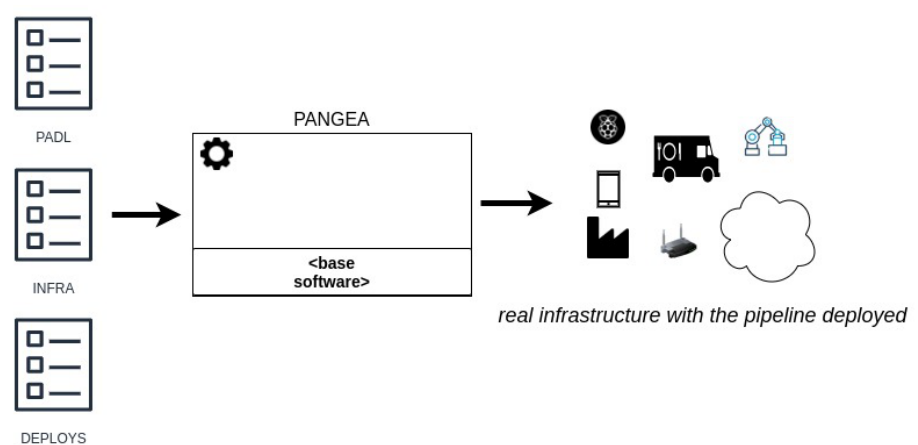
Figure 6. Process for automatically generating and configuring the required missing infrastructure, and packaging, deploying, and serving the analytic